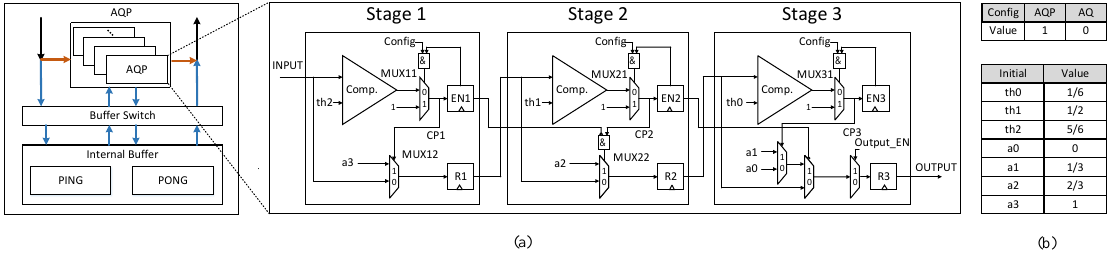
Figure 8. ( a ) Reconfigurable three-stage AQP unit, ( b ) Config: mode and initial